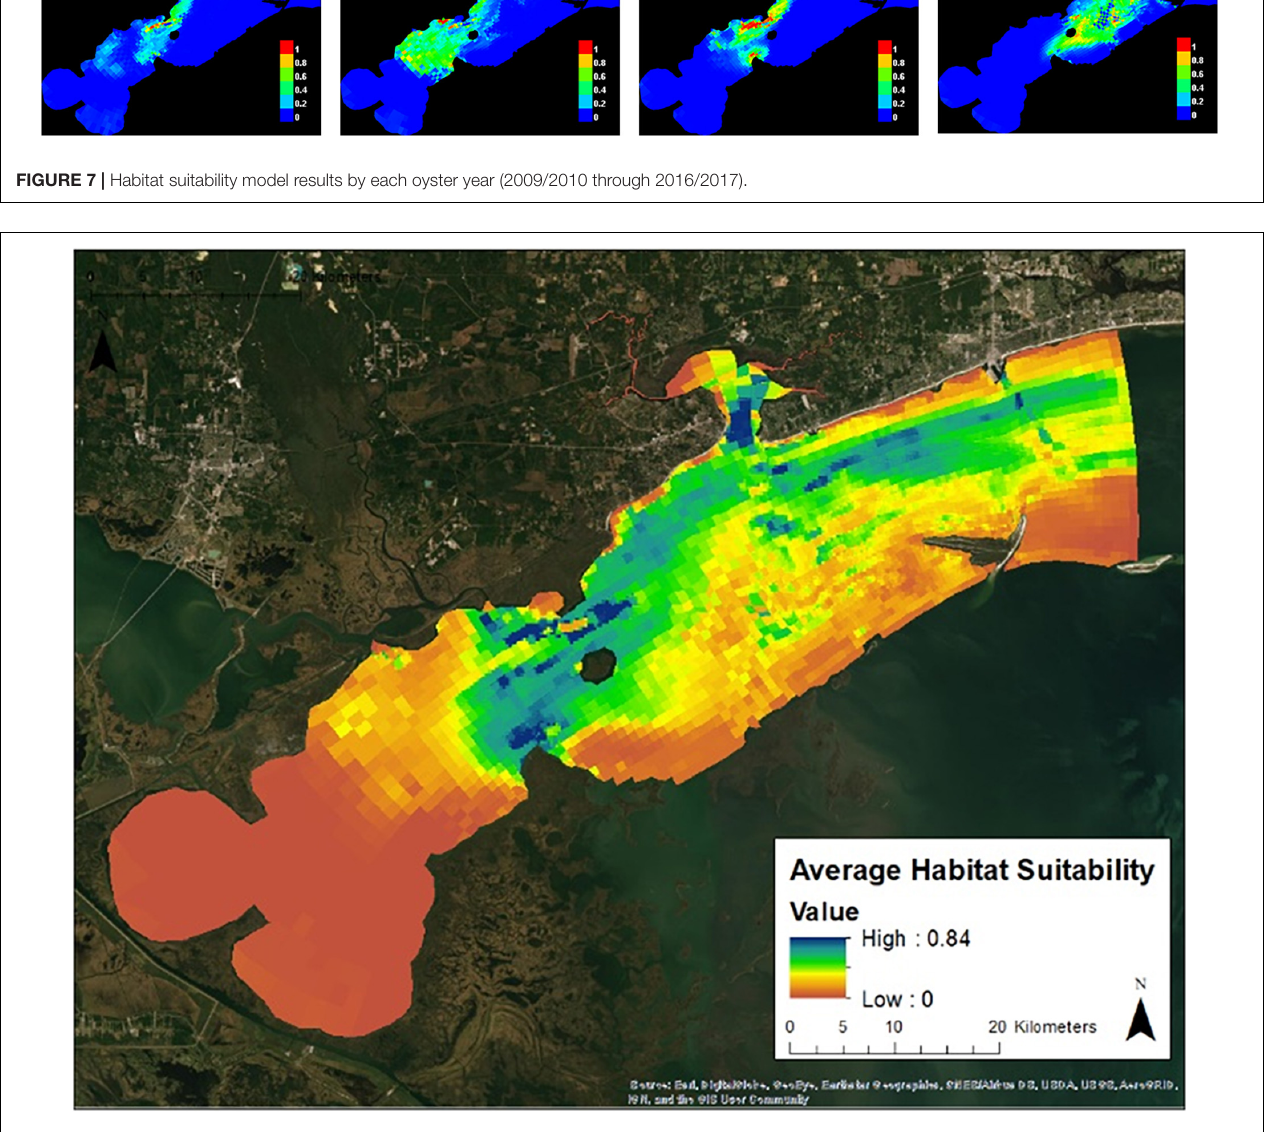
FIGURE 8 | Average habitat suitability between the 2009/2010 and 2016/2017 oyster